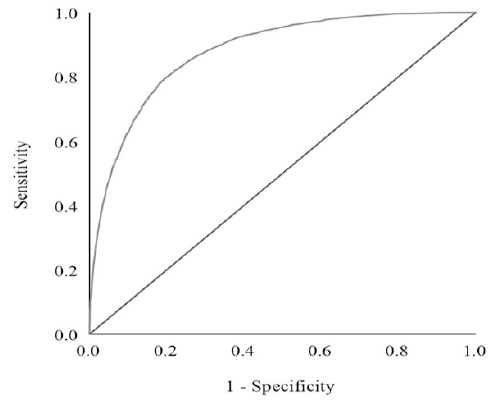
Figure 2. ROC curve of the frailty risk prediction model.